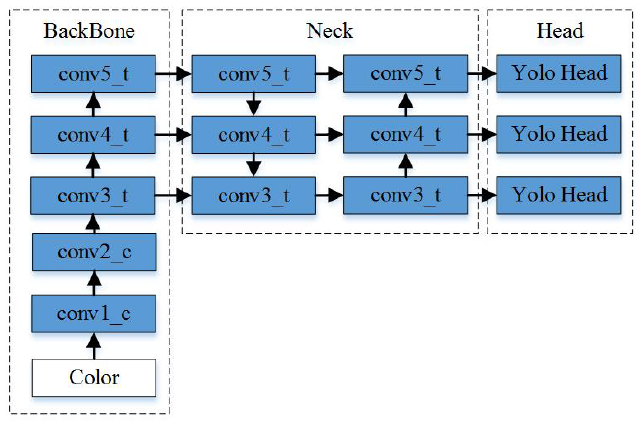
Figure 2. Overall object detection architecture of